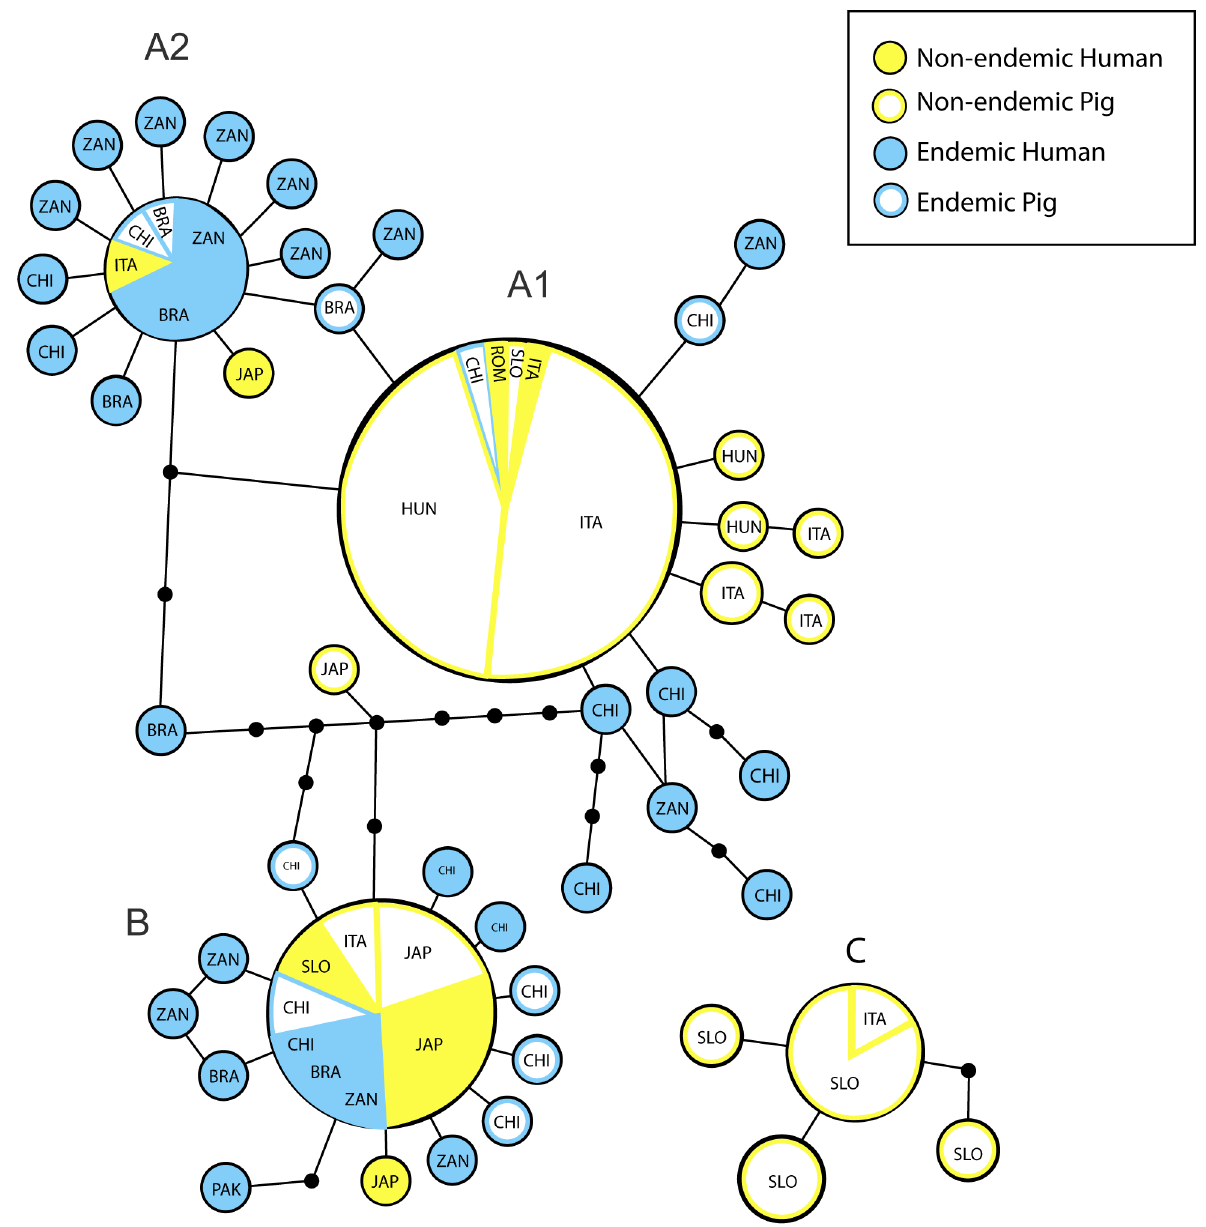
Figure 3. Parsimony network of Ascaris haplotypes. Parsimony network of the haplotypes observed in the Dataset2, with 95% connection limit. Circles diameter is proportional to haplotypes frequency; circles at branches represent SNPs (A=Cluster A, including subclusters A1 and A2; B=Cluster B; C=Cluster C).